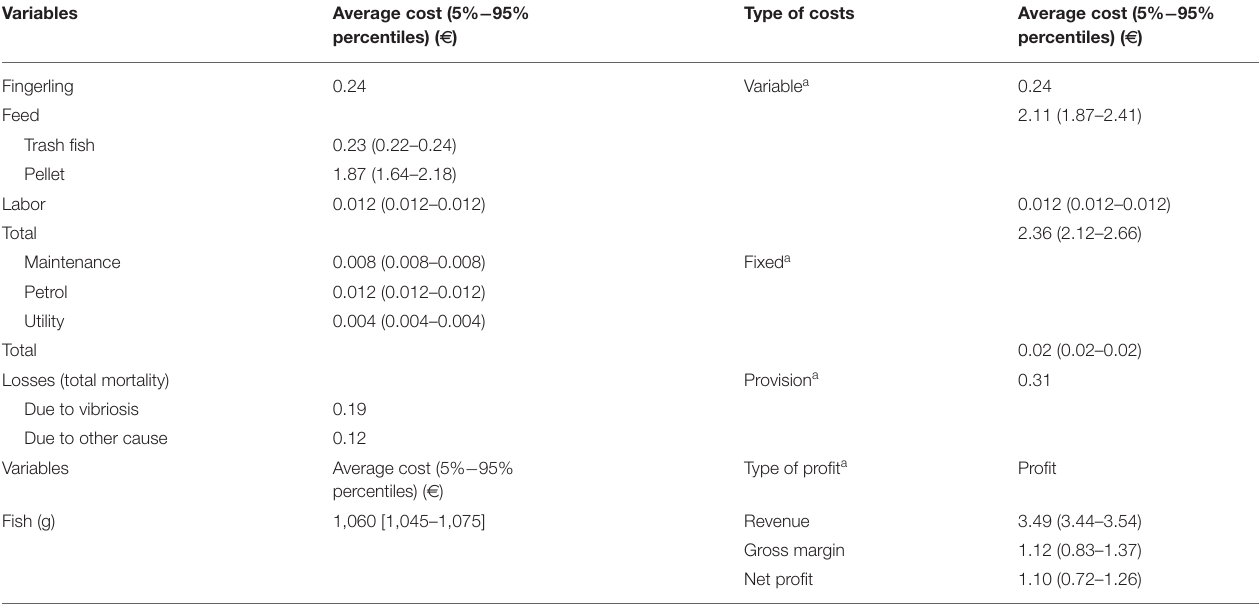
TABLE 7 | The cost of grow-out for Asian seabass in cage culture per tail from 20 to 1,060g (5–95% percentiles: 1,045–1,075g) within 210 days of using the stochastic